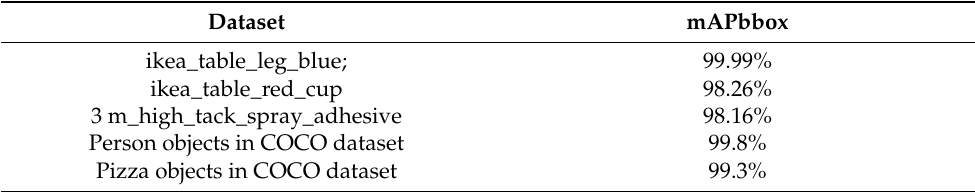
Table 1. Results of recognition accuracy with different datasets.